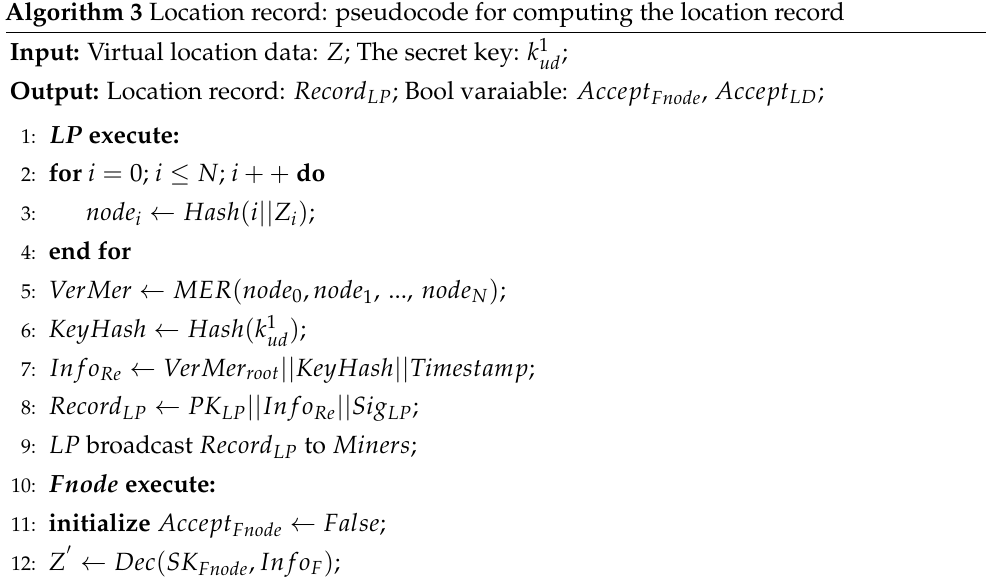
Algorithm 3 Location record: pseudocode for computing the location